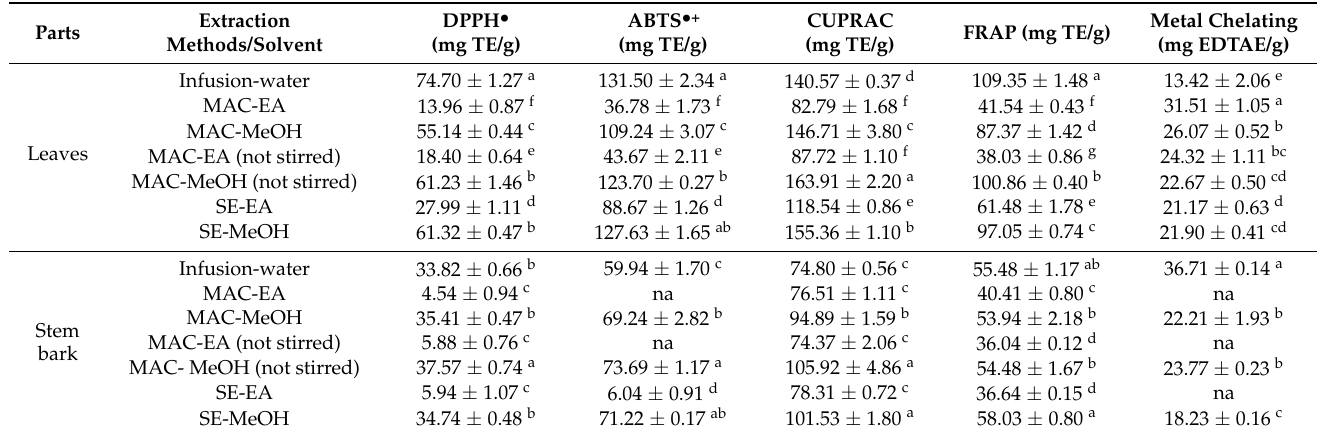
Table 8. Antioxidant properties of the studied extracts *.